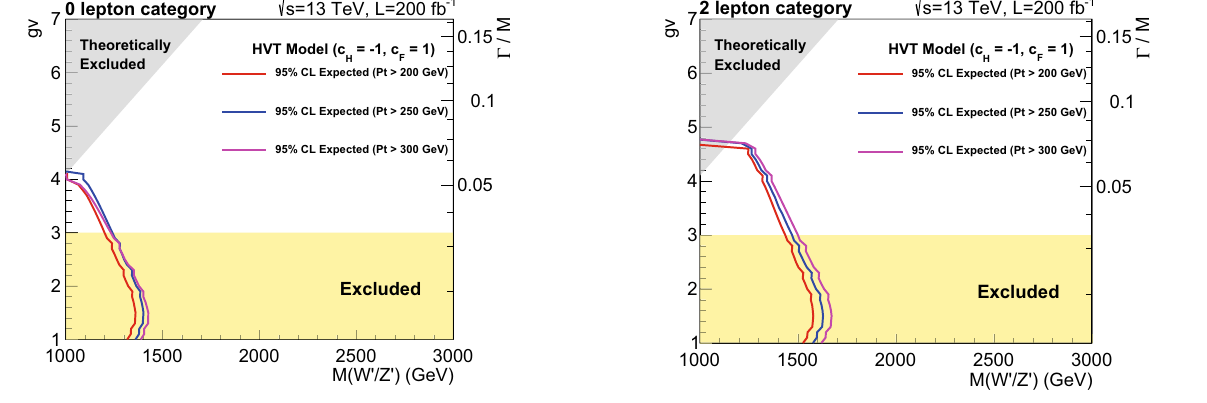
Fig. 10 Expected 95% CL HVT limits as a function of the reso- nance mass and width, for an integrated luminosity of 200 fb − 1 . The limits for the 0-lepton category are shown for increasing p ⊥ > 200 , 250 , 300 GeV selections. The theoretically excluded regions cor- respond to regions of small physical mass and large g V coupling, where the HVT model cannot reproduce the SM input parameters α EW , G F and M Z